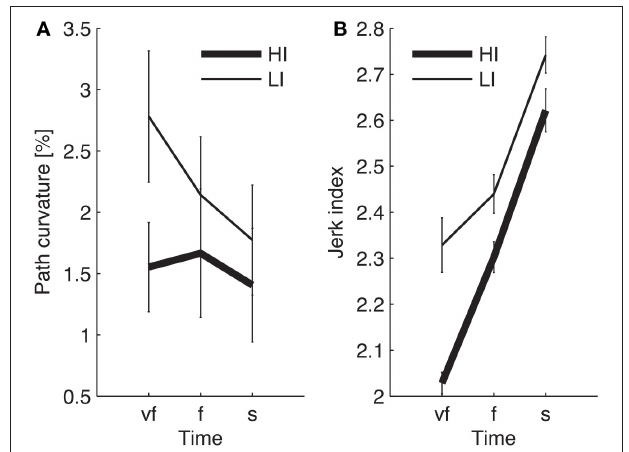
FIGURE 4 | Dependence of path curvature (A) and jerk index (B) curves on inertia. Thin and thick lines denote, respectively, low (LI) and high inertia (HI) directions. Vertical bars denote the SE .